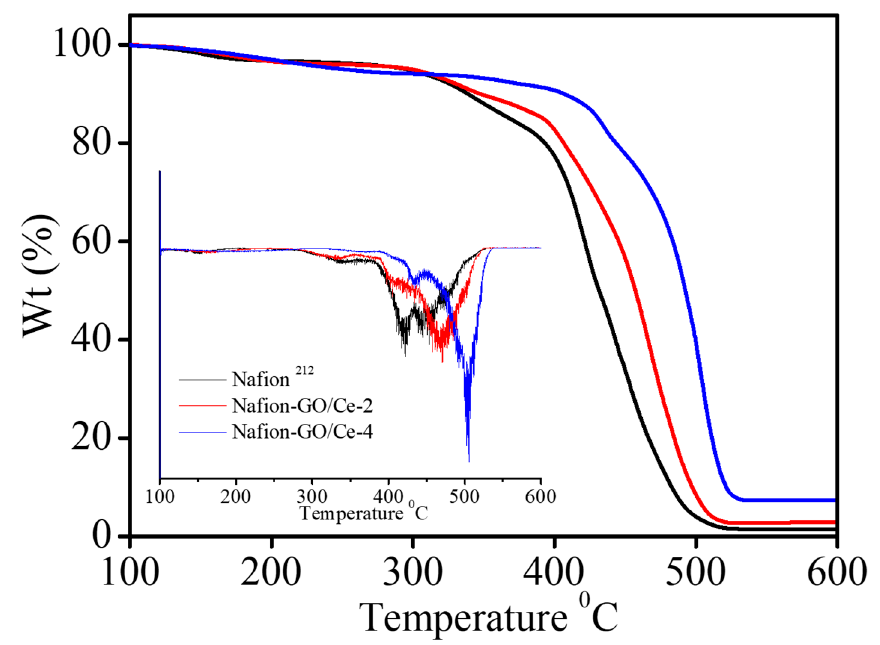
Figure 5. TGA and dTg (inset) graph of Nafion 212 and composite membranes.